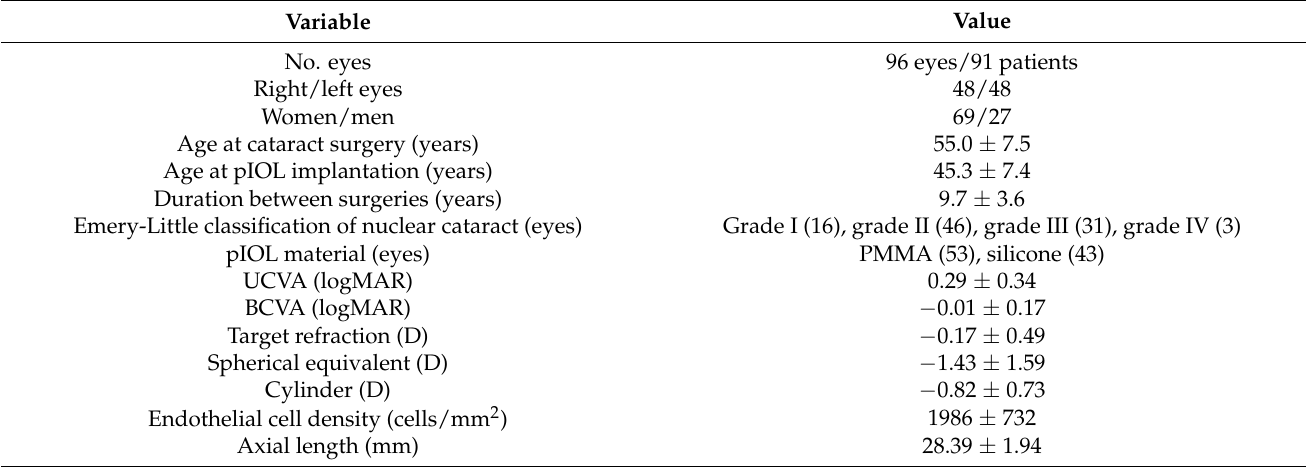
Table 1. Demographic data of the study